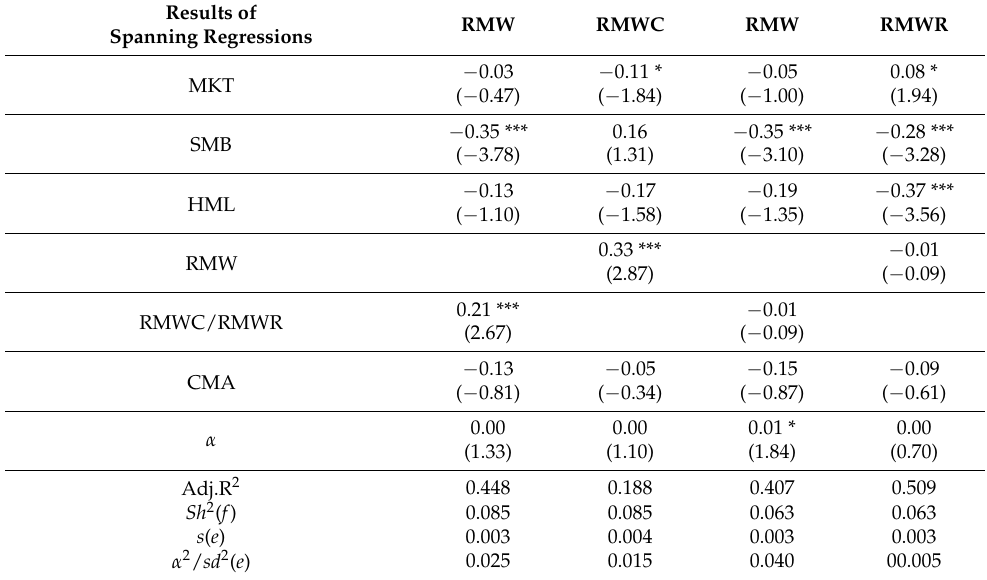
Table 9. Testing the profitability factors. The table reports the results of time-series regressions with each of the profitability variables (operating profitability (RMW), cash profitability (RMWC) and ROE profitability (RMWR)) being regressed by the remaining five factors. MKT is the value-weighted excess return on the market portfolio, and SMB is the average return on the portfolio sorted by size. HML is the value factor sorted by size and book-to-market ratio. RMW is the operating profitability factor (Fama and French 2015). RMWC is the cash profitability factor (Fama and French 2018; Ball et al. 2015). RMWR is the ROE profitability factor (Hou et al. 2015, 2019). CMA is the investment factor. All factors are 2 × 3 portfolios constructed using the Fama and French (1993, 2015) methodology. Sh 2 ( f ) is the maximum squared Sharpe ratio for a model’s all 6 factors. α , s ( e ) and α 2 / sd 2 ( e ) are the factor’s intercept, residual standard error from spanning regressions and the marginal contribution of a factor to a model’s Sh 2 ( f ), respectively. Newey–West t -statistic is given in parentheses. The sample is from September 2008 to July